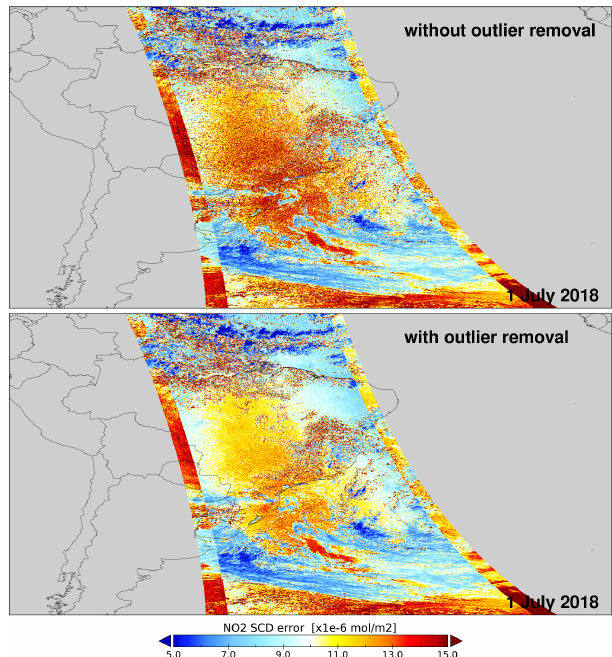
Figure A1. Map of the TROPOMI NO 2 SCD error without (top panel) and with (bottom panel) outlier removal, the difference of which is shown in the top panel of Fig.